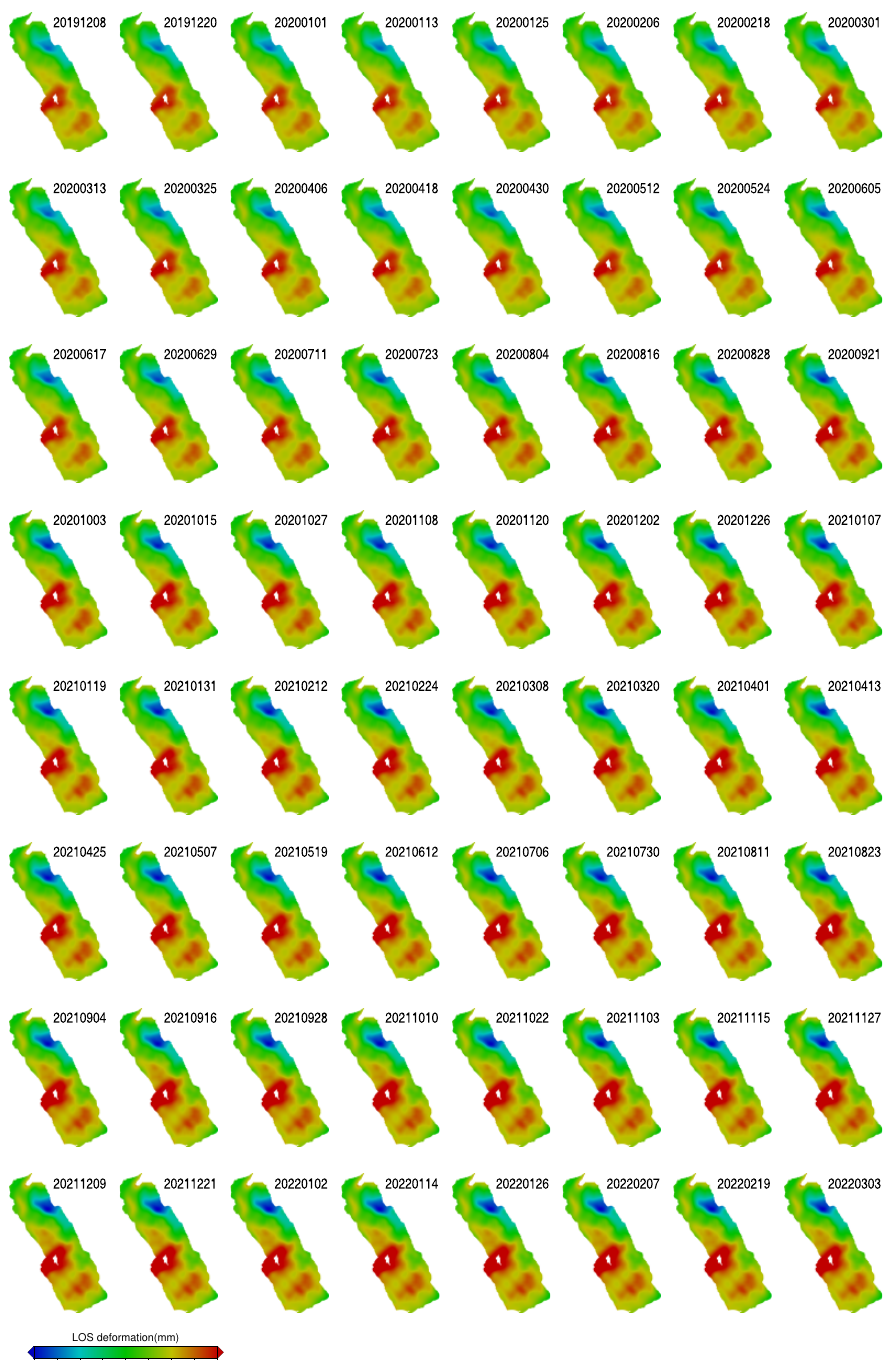
Figure 5. LOS displacement time-series maps for the Guang’an Village Landslide at the 128 Sentinel-1 acquisition date, referring to the first SAR image acquired on 31 October 2017 (from 8 December 2019 to 3 March 2022). The number at the upper right of each subplot represents the image acquisition date (in yyyymmdd